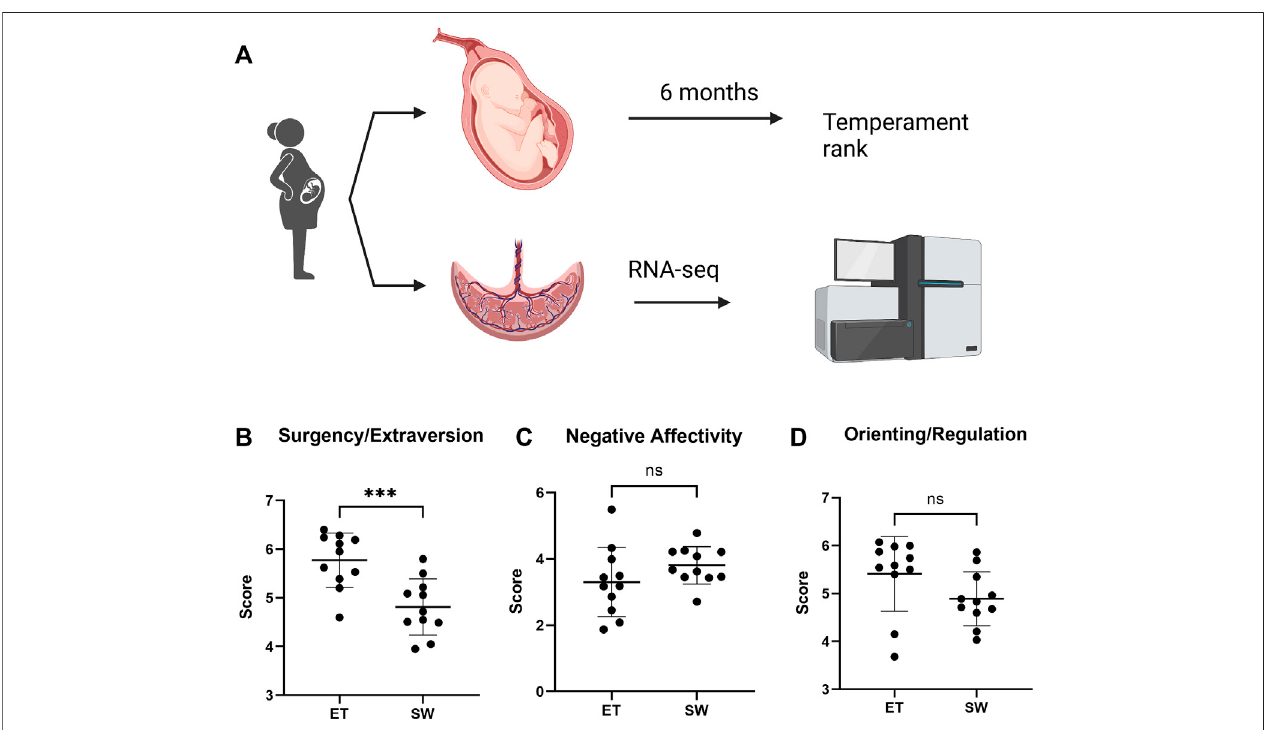
FIGURE 1 | Assessment of infant temperament score at 6 months of age in children exposed to Superstorm Sandy in utero . (A) Experiment outline (B) Temperament was assessed at 6 months of age. Compared with infants with an easy temperament (ET), the Surgency/Extraversion score was signi fi cantly reduced in infants with Slow-to-Warm-up temperament (SW). Compared with infants with ET, a trend towards increased Negative Affectivity (C) and decreased Orienting/ Regulation (D) , was observed in the SW temperament infants, although the differences did not reach statistical signi fi cance. Data represented as mean ± SD. ppp denotes p = 0.0008 by unpaired